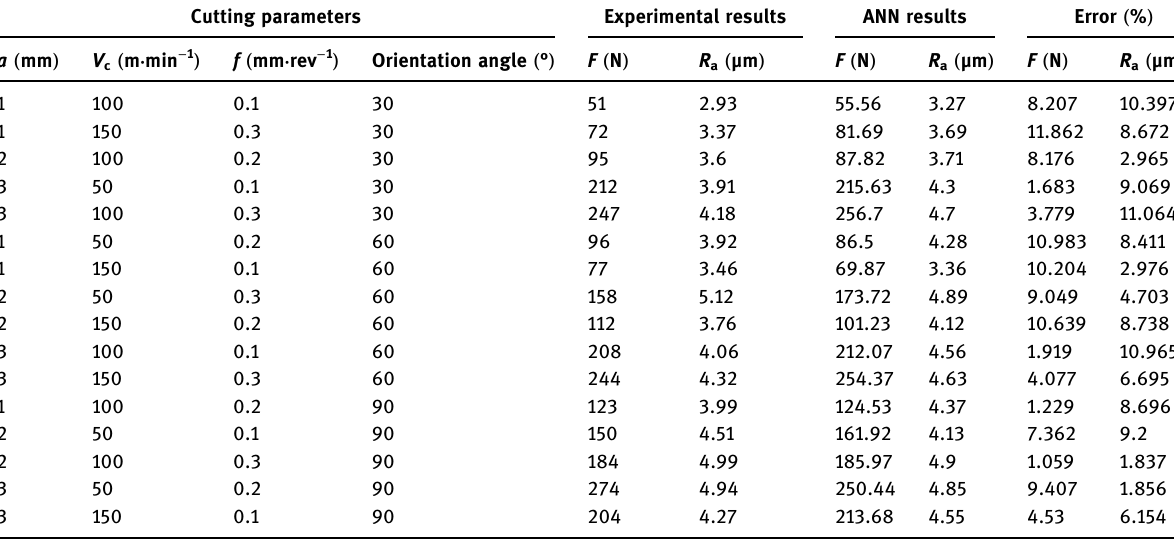
Table 3: Results from experimental study and ANN model Cutting